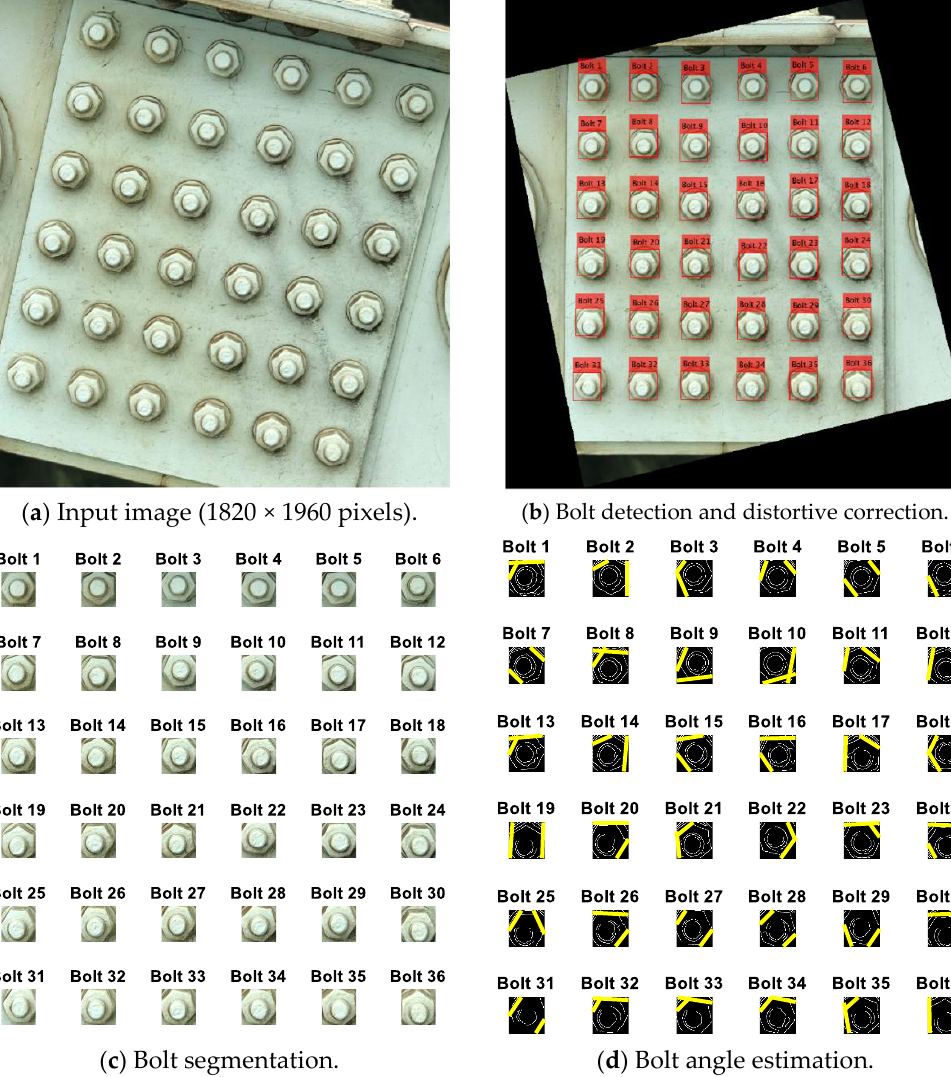
Figure 14. Bolt angle estimation of the included bolted connection.